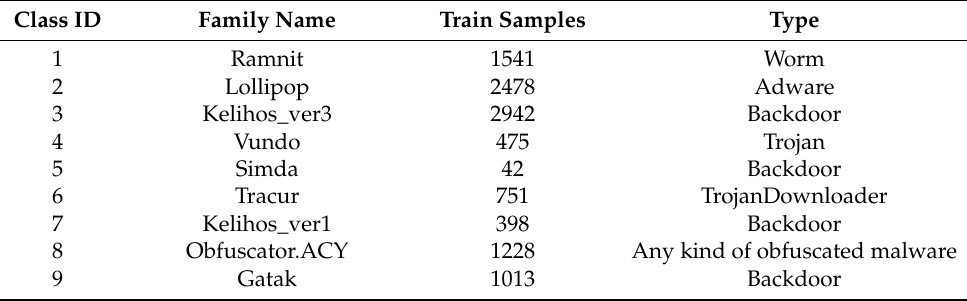
Table 3. Malware families in the training